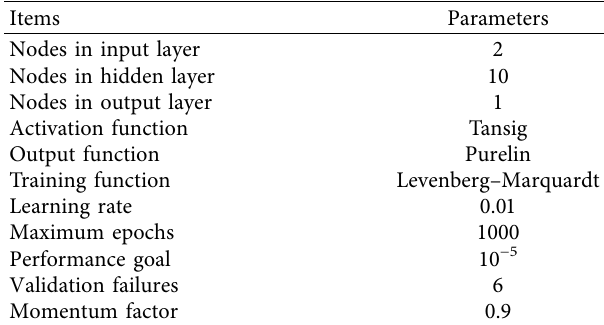
Figure 3: The flowchart of the BP neural network for estimating junction temperature. Table 1: BP neural network training